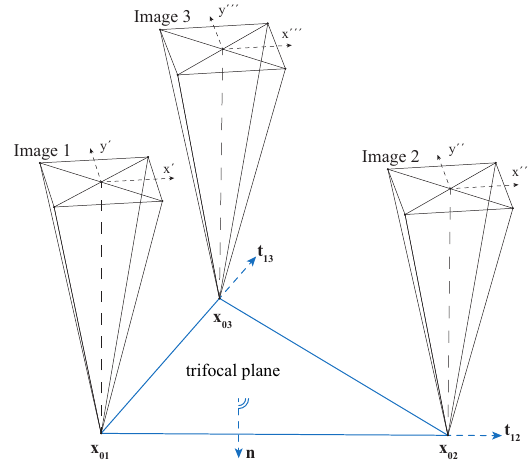
Figure 2. Camera arrangement and trifocal plane Consequently, the new camera´s line of sight axis (z-axis) must be perpendicular to the trifocal plane and hence is equal to the normal vector n . The normal vector can be calculated by the cross product of the vectors t 12 and t 13